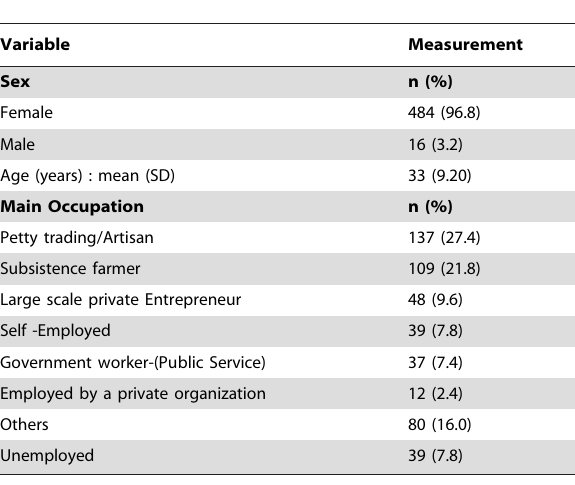
Table 1. Socio-demographic characteristics of respondents (N= 500).